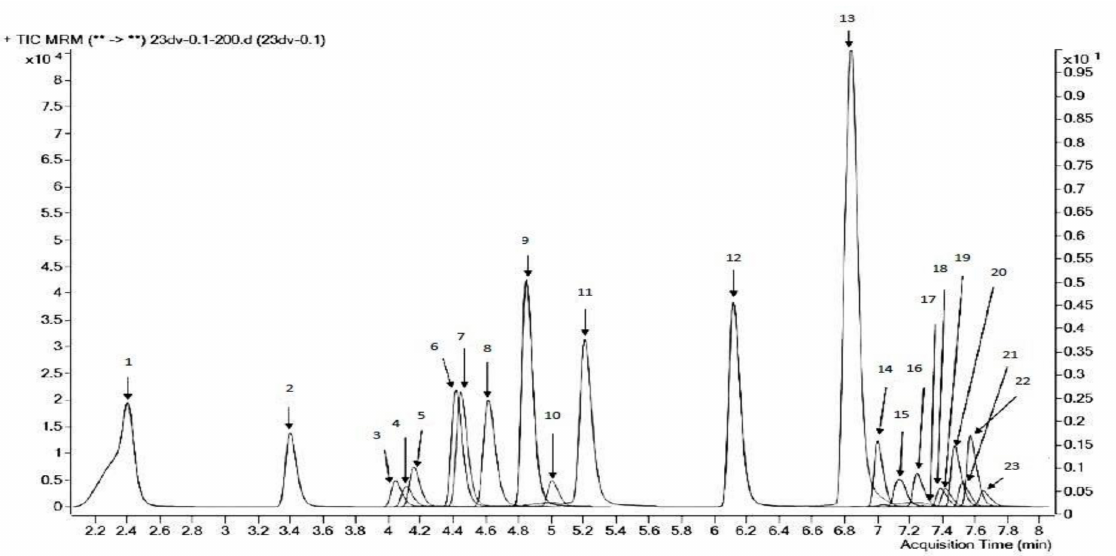
Figure 1. Chromatogram of the model solution of 23 pesticides with the concentration of 0.1 µ g · ml − 1 , the electrospray ionization source (ESI) in the positive ion mode (TIC—total ion current): 1—omethoate, 2—thiamethoxam,